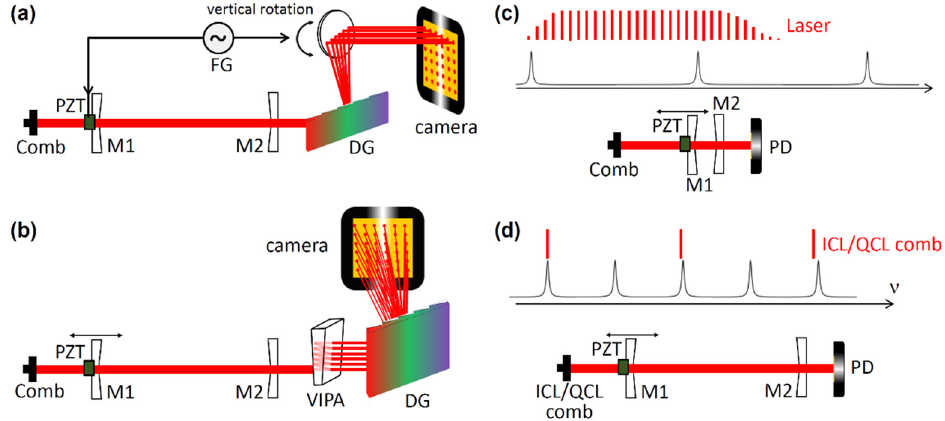
Figure 3. Typical detection schemes of comb-resolved Vernier spectroscopy. ( a ) Spectrometer based on an fs laser, diffraction grating, a rotating element, and a detector array. M1,2: cavity mirrors; PZT: piezo transducer; DG: diffraction grating; FG: frequency generator. ( b ) Spectrometer based on an fs laser, virtually imaged phase array (VIPA), stationary diffraction grating and a detector array. ( c ) Spectrometer based on an fs laser and a microcavity with a single photodiode detection (PD). ( d ) Spectrometer based on a chip-scale comb. The upper panels in ( c , d ) show the comb–cavity matching.